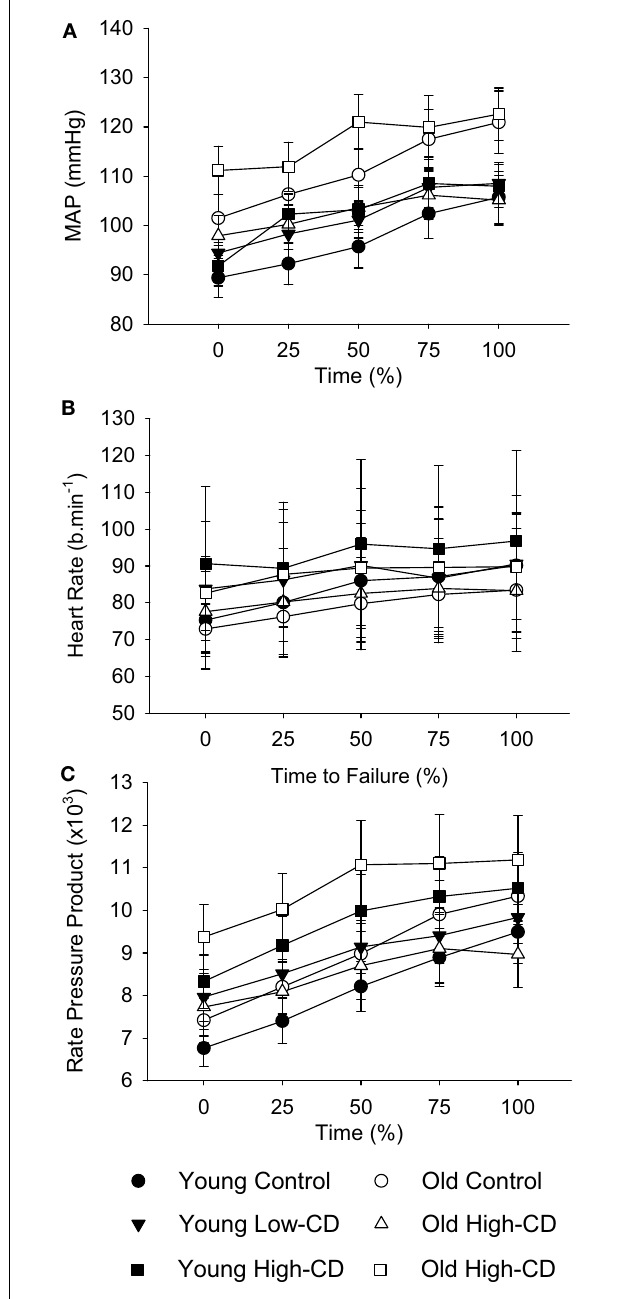
FIGURE 6 | Mean arterial pressure, heart rate, and rate-pressure product during the fatiguing contraction for young and older adults across sessions. The values are mean ± SE at 25% increments of time to task failure for young (closed symbols) and older (open symbols) adults during the control (circles), low-cognitive demand (Low-CD, triangles), and high-cognitive demand (High-CD, squares) sessions for mean arterial pressure (A) , heart rate (B) , and rate-pressure product (C) during the fatiguing contraction. Averages of 15-s intervals were used for the MAP and heart rate. Rate-pressure product was the product of heart rate and MAP for the equivalent time periods in (A,B)